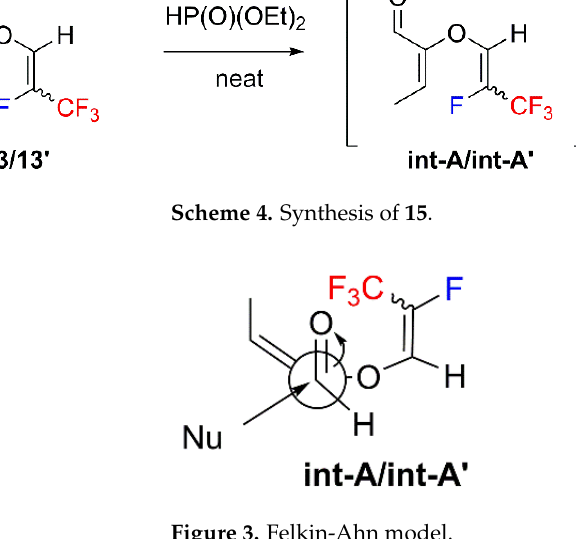
Figure 3 . Felkin-Ahn model. Figure 3. Felkin-Ahn